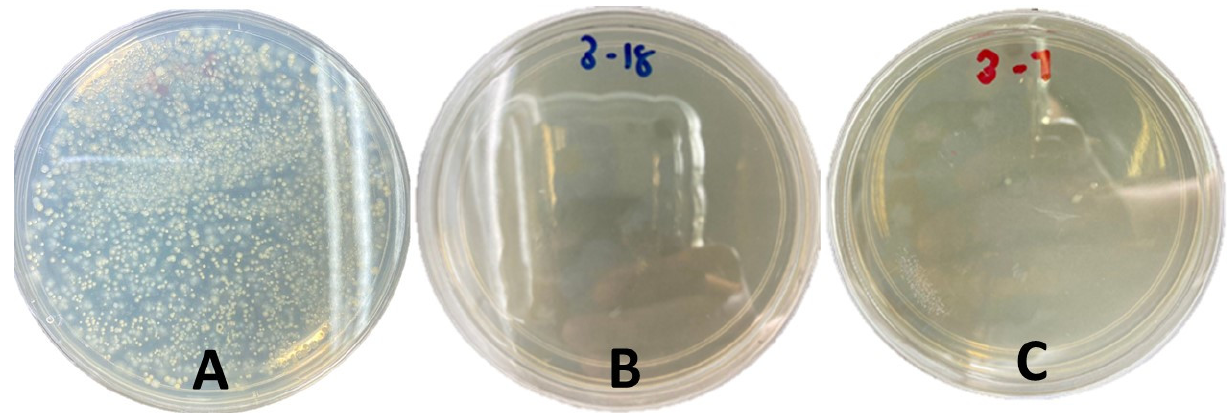
Figure 14. Antimicrobial analysis on nutrient agar (NA). Control ( A ), RTDW ( B ) and STDW ( C ). The samples were incubated for 24 h at room temperature.